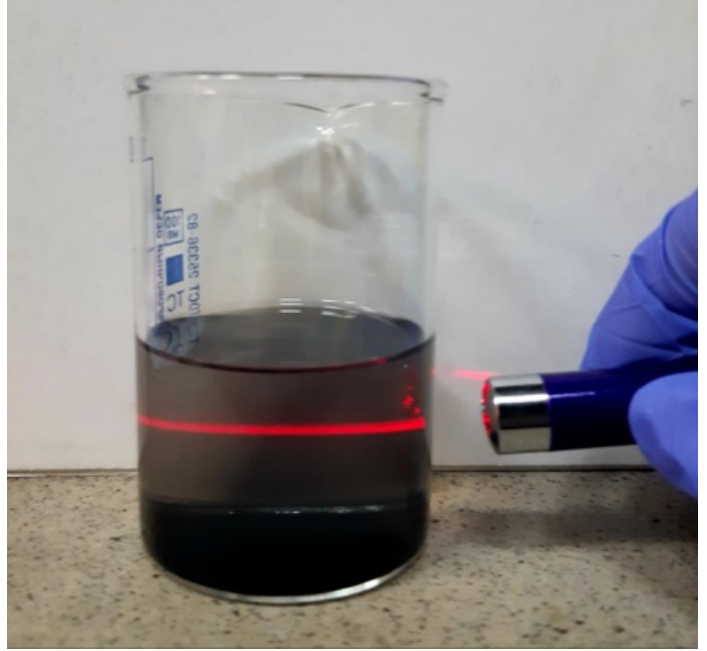
Figure 1. Tyndall effect in the graphene suspension in isopropanol after 24 hr exfoliation. According to the Raman shown in Figure 2, all of the bands characteristic of the oxygen-free graphene, are present in the obtained spectrum. In the region of 1567 cm − 1 , the main spectral characteristic is observed in the form of a narrow band G, which arises as a result of the stretching vibrations in the plane of the carbon atoms bound by the sp 2 bonds. The small width of the G band indicates the predominance of a low-layer, low-defect oxygen-free graphene. The latter is also confirmed by the EELS analysis data (inset): the absence of the 532 eV peak, characteristic of the oxidized graphene indicates the absence of the O-containing functional groups on the surface of the graphene sheets. At the same time, a broad peak centered at 284 eV, indicates the transition from 1s to π * and confirms the presence of the sp 2 carbon atoms in the system. The D band in the region of 1347 cm − 1 , characterizes the degree of disorder in the electronic structure of the carbon layers, which occurs when the lattice moves from the middle of the Brillouin zone. A large value